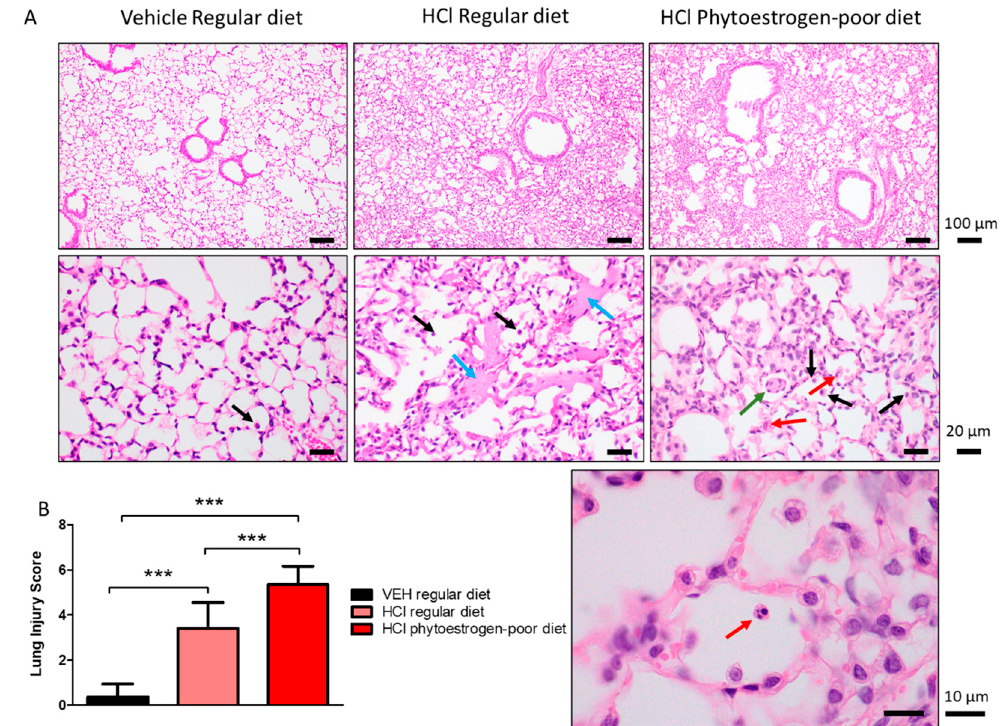
Figure 2. HCl causes chronic lung injury. ( A ) H&E staining of lung sections demonstrates monocyte infiltration and hyaline membranes in regular diet-fed, HCl-instilled mice, edema, septal thickening, monocyte, and neutrophil infiltration in isoflavone-poor diet-fed mice. ( B ) Lung Injury Score is maximal in HCl-instilled mice, on phytoestrogen-poor diet, still high but lower in HCl-instilled mice on regular diet and without significant changes in saline-instilled mice. (Means ± SEM; n = 3; ***: p < 0.001; with one-way ANOVA and Tukey’s); VEH: Vehicle.